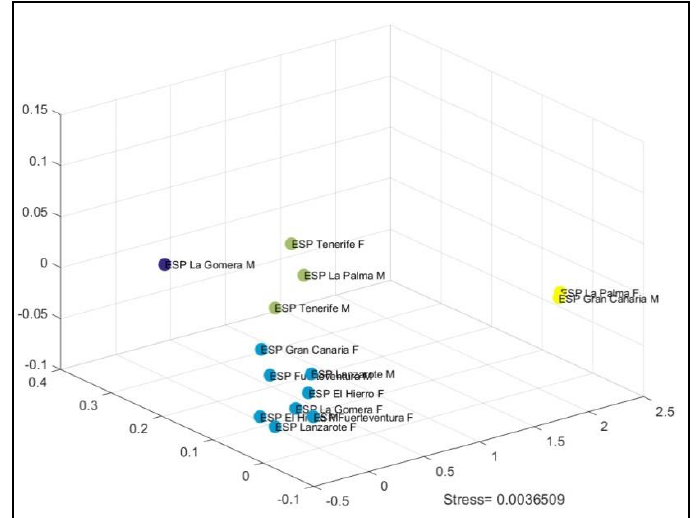
Figure 6. Three-dimensional MDS of SVO declarative sentences with the value of Stress.